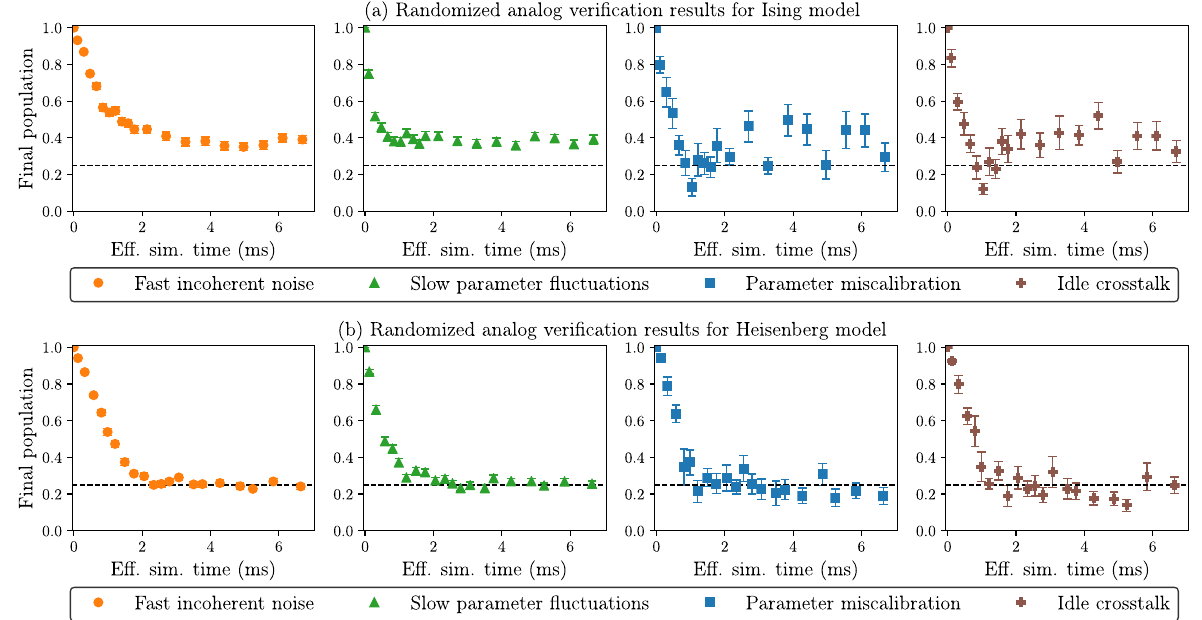
Fig. 8 Numerical two-qubit simulation results of veri fi cation protocols for two different Hamiltonians. Two-qubit numerical simulations showing randomized analog veri fi cation results for two Hamiltonians under four different types of experimental error sources: fast incoherent noise (~ τ / n ) in Hamiltonian parameters, slow fl uctuations ( ≫ τ ) in Hamiltonian parameters, constant miscalibration of Hamiltonian parameters, and constant idle crosstalk affecting all sites. The "effective simulation time'' is the average time for which each term of the Hamiltonian is enabled. Each data point represents the distribution of ten different randomly generated sequences, with each sequence simulated 15 times. Error bars indicate standard error of the mean. Dashed line added at y = 0.25 on each plot as a visual aid. a The target Hamiltonian is the one- dimensional Ising model from Eq. (33) under fast incoherent noise with 12% relative standard deviation (RSD), slow parameter fl uctuations with 6% RSD, parameter miscalibration with 3% RSD, and idle crosstalk with 3% RSD. b The target Hamiltonian is the one-dimensional Heisenberg model from Eq. (34) under fast incoherent noise with 4% RSD, slow parameter fl uctuations with 2% RSD, parameter miscalibration with 1% RSD, and idle crosstalk with 1% RSD. For both a and b , we choose b = J x = J y = J z = 2 π × 20 kHz. Note that larger relative errors are used in a to compensate for the smaller number of Hamiltonian terms in this simulation, such that the decay times of the plots in a and b are